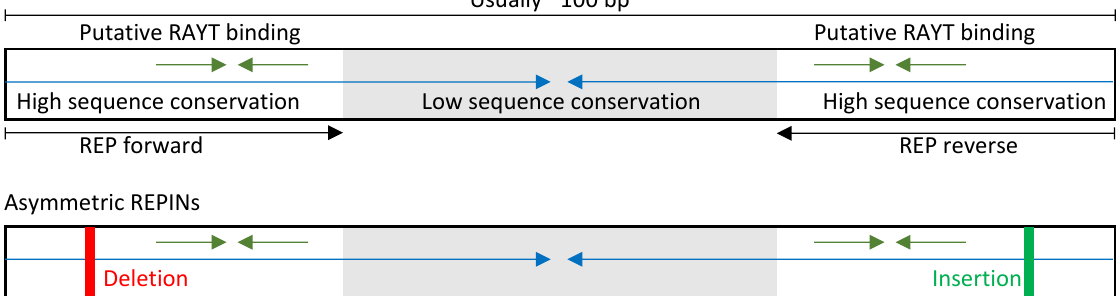
Figure 1 - The structure of symmetric and asymmetric REPINs. A typical REPIN consists of two highly conserved regions at the 5’ and 3’ end (white), separated by a spacer region of lower sequence conservation (grey). The entire REPIN is an imperfect palindrome (blue arrows), which means it can form hairpin structures in single stranded DNA or RNA. Each 5’ and 3’ region contains a nested imperfect palindrome, which is referred to as REP (repetitive extragenic palindromic) sequence and has first been described in Escherichia coli (Higgins et al. 1982). REPINs can be either symmetric or asymmetric. Asymmetric REPINs have a deletion and a corresponding insertion in the highly conserved 5’ or 3’ end, which leads to “bubbles” in the hairpin structure. REPINs in for example Pseudomonas fluorescens SBW25 are symmetric while REPINs in E. coli are asymmetric. Asymmetric REPINs make analyses with RAREFAN more challenging. Figure adapted from (Bertels, Rainey 2023), which is licensed under CC BY